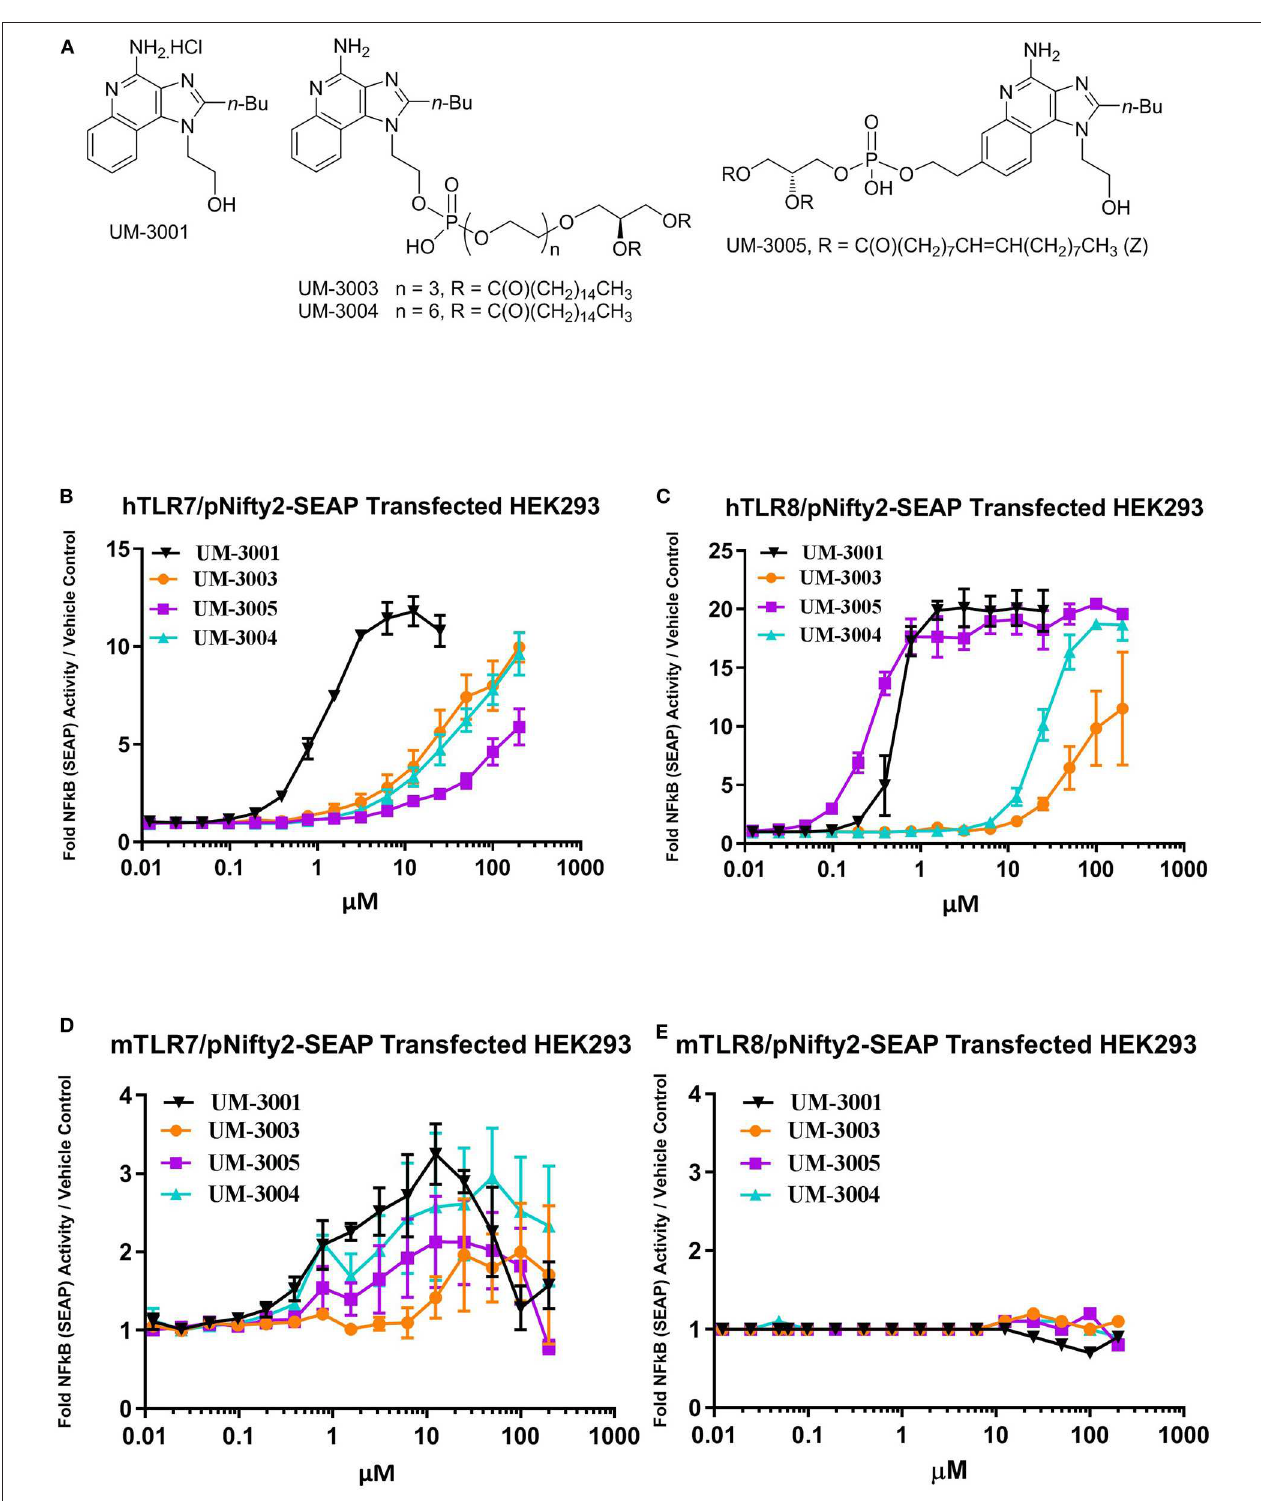
FIGURE 1 | Novel imidazoquinolines as TLR7/8 agonists. (A) Chemical structures of synthesized imidazoquinoline small molecules. (B,C) Activity of imidazoquinolines in human embryonic kidney (HEK) reporter cells expressing human TLR7 ( B ; n = 2) or human TLR8 ( C ; n = 2). (D,E) Activity of imidazoquinolines in human embryonic kidney (HEK) reporter cells expressing mouse TLR7 ( D ; n = 3) or mouse TLR8 ( E , n = 3). In b-e, cells were stimulated with imidazoquinolines formulated in 2% glycerol at the indicated concentrations for 24h. HEK reporter activity is expressed as fold change over media only control.